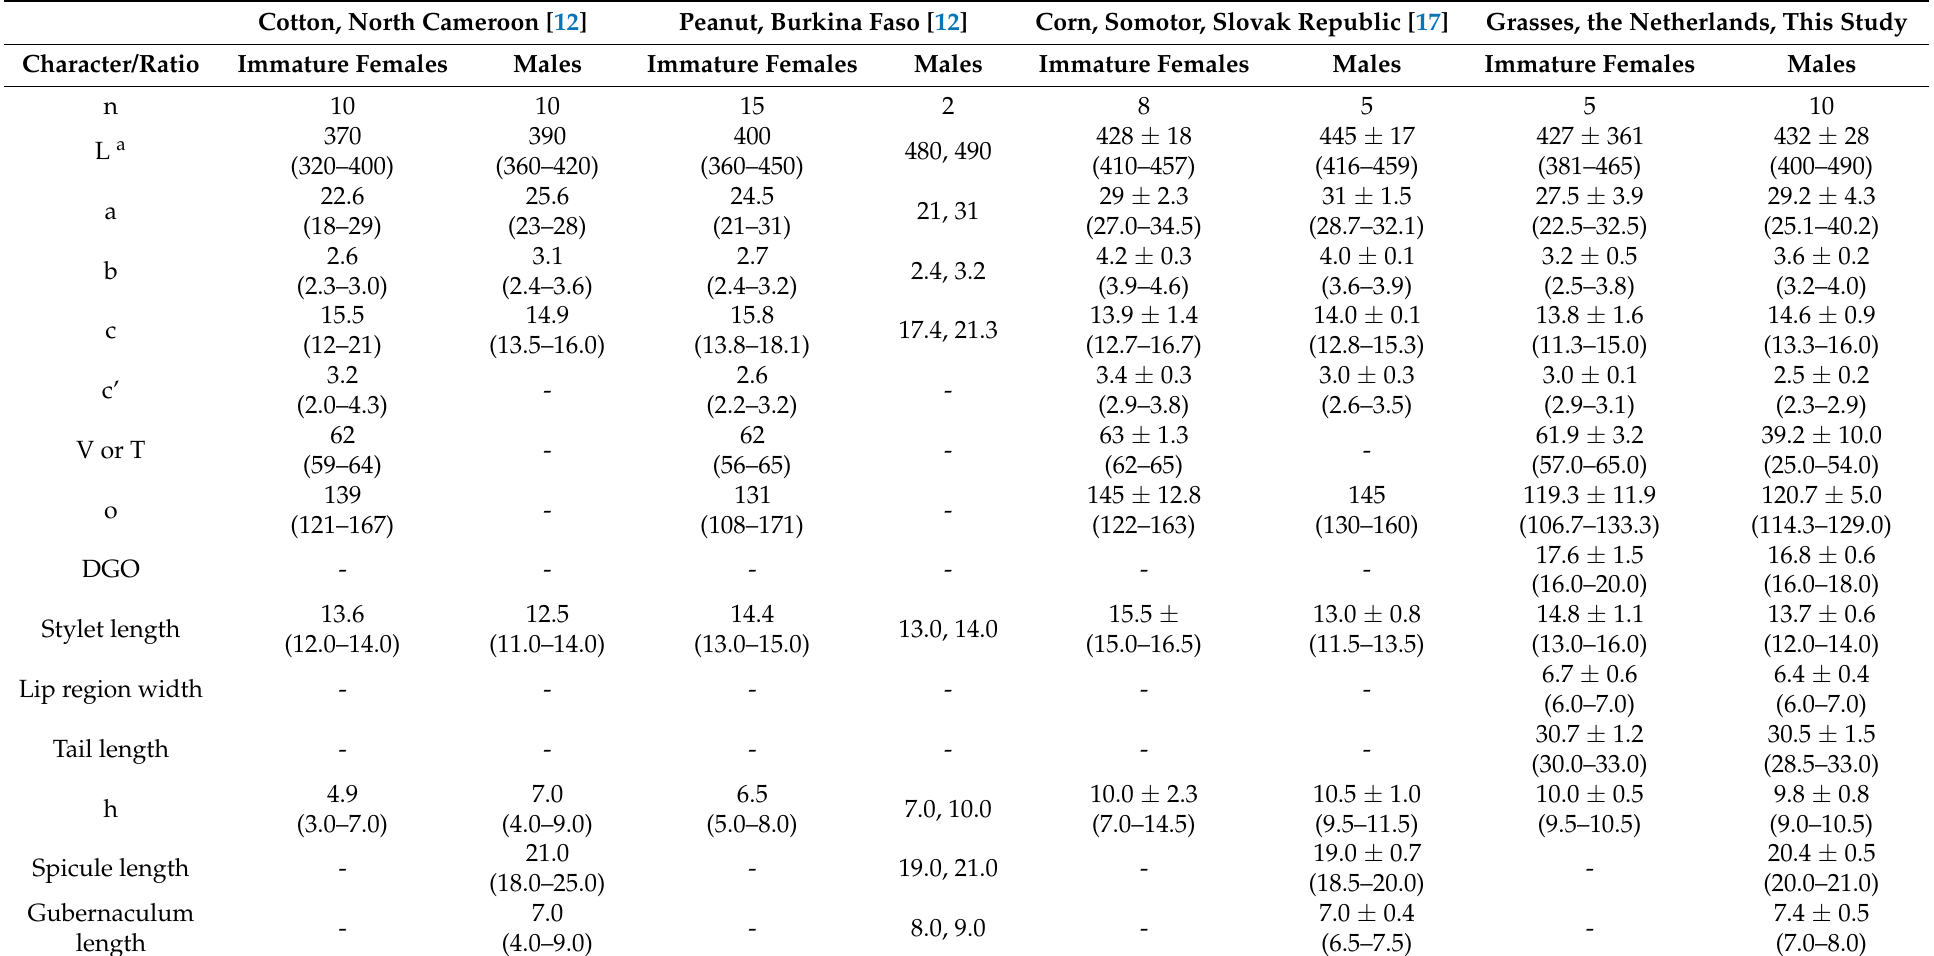
Table 4. Measurements of immature females and males of Rotylenchulus borealis from several localities in Africa and the Slovak Republic. All measurements are in micrometers and in the form mean ± SD